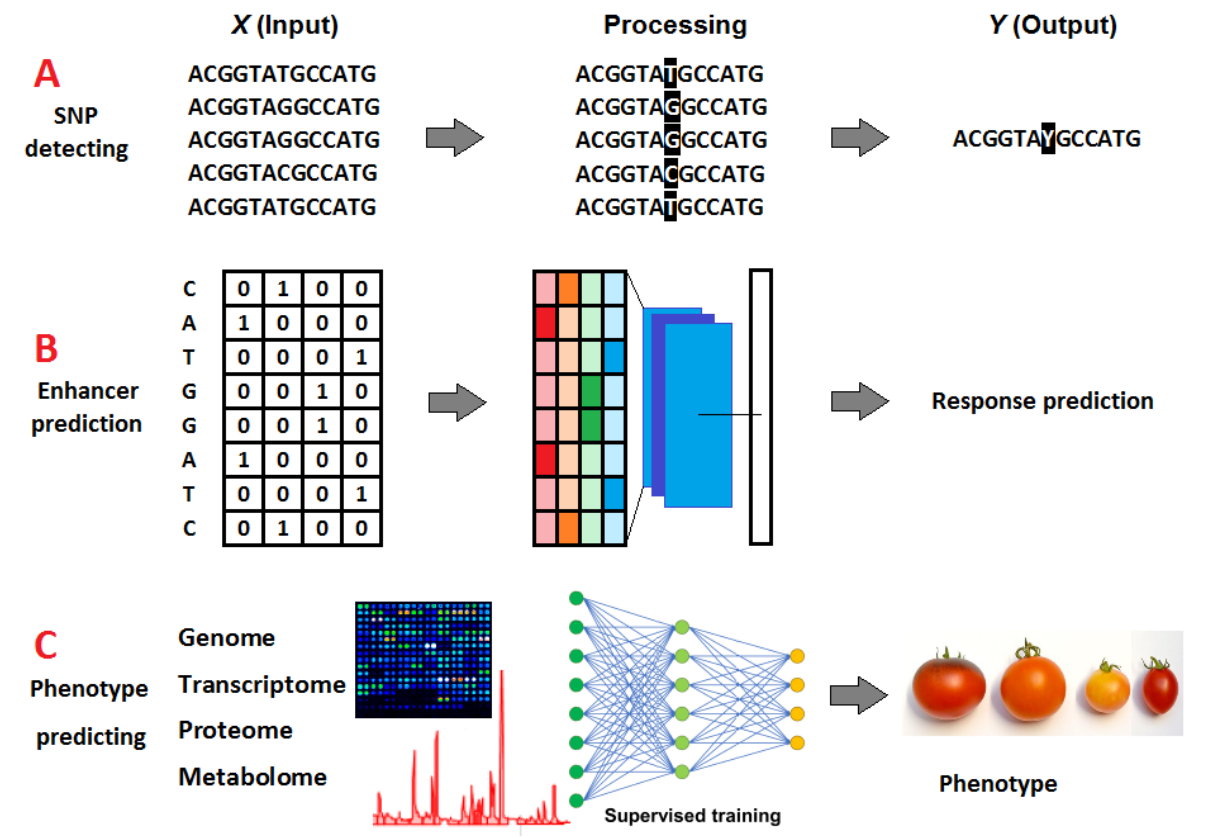
Figure 2. Examples of deep learning applications in omics.